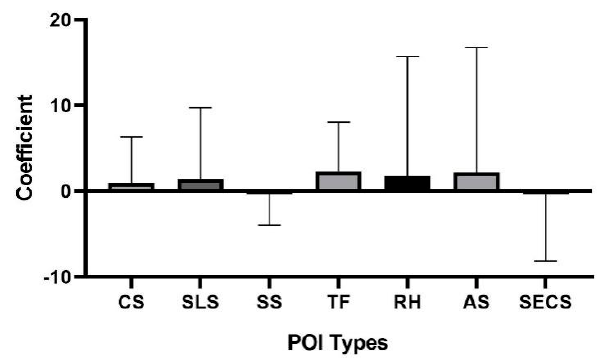
Figure 7. Correlation coefficients with POIs.